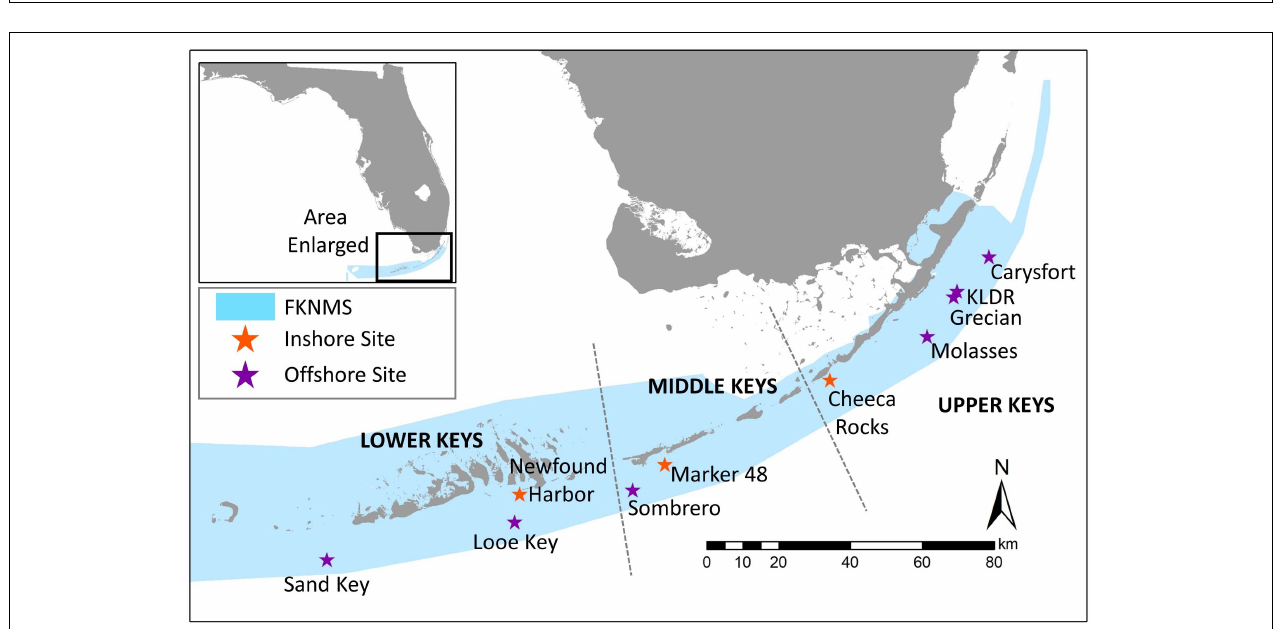
FIGURE 2 | Location of coral disease treatment sites within the Florida Keys National Marine Sanctuary (FKNMS). Regions are defined as lower, middle, and upper Keys. Colors represent inshore (orange) and offshore (purple)